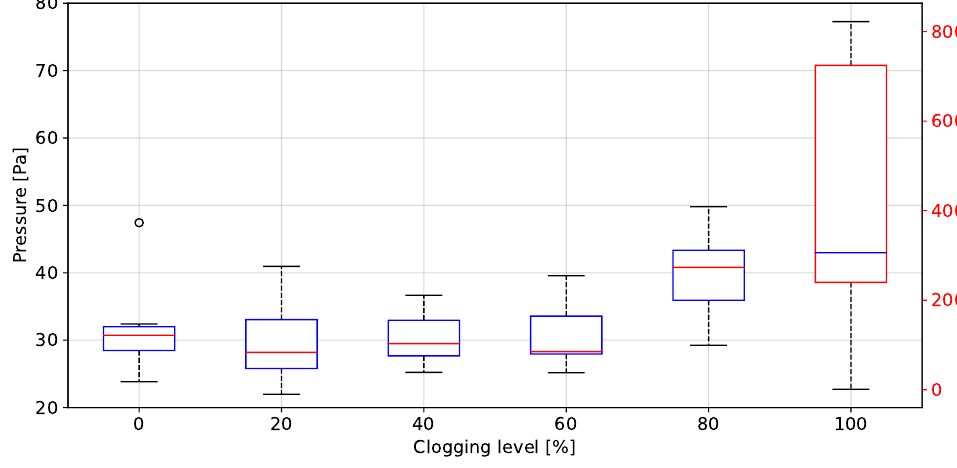
Figure 21. Peak to peak values of pressure as a function of the clogging level.